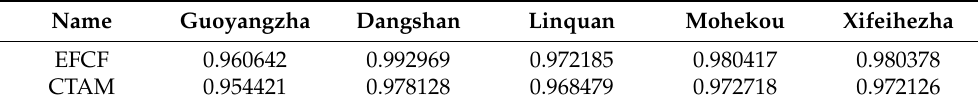
Table 3. Cumulated relative fitting error (CRFE) of annual precipitation in northern Anhui province,